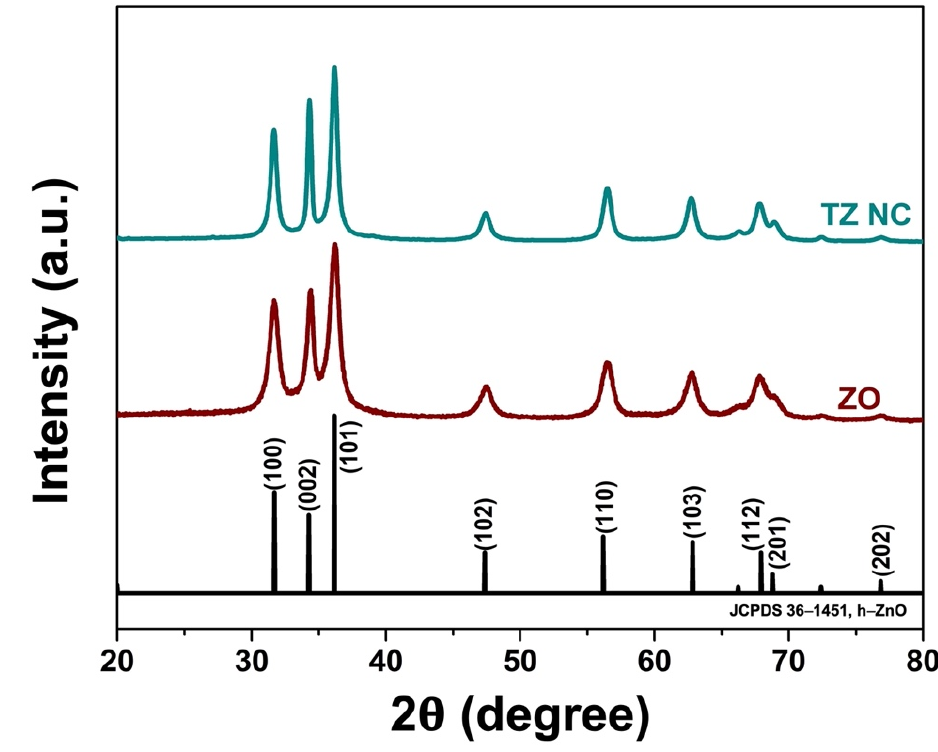
Figure 1. X-ray diffraction (XRD) patterns of the ZO and TZ NC samples.